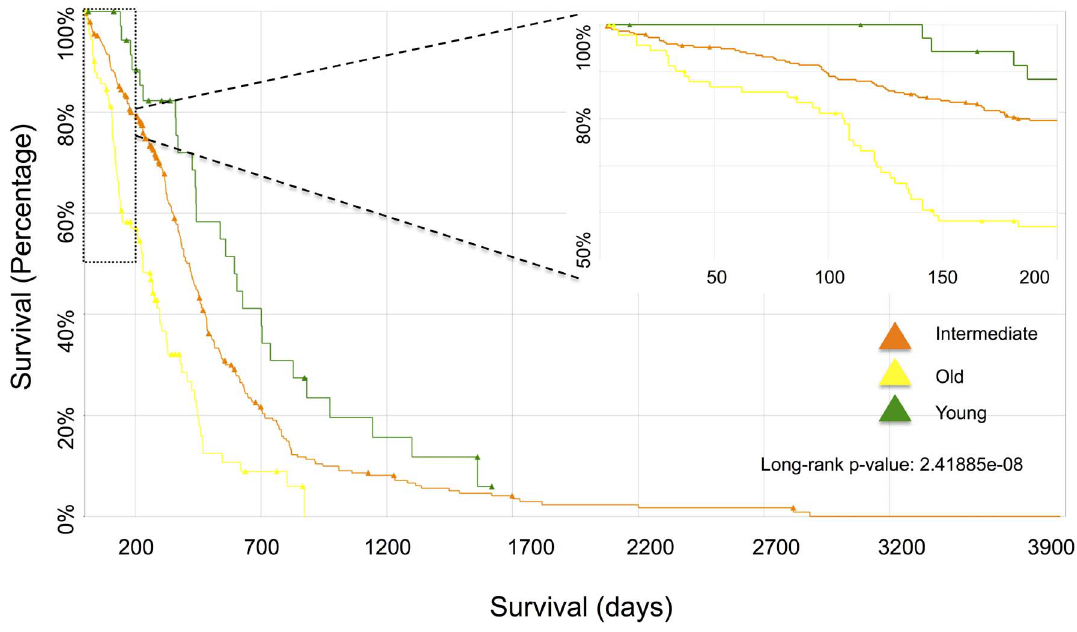
Figure 2. Kaplan-Meier plot between old, young, and middle-aged GBM samples.